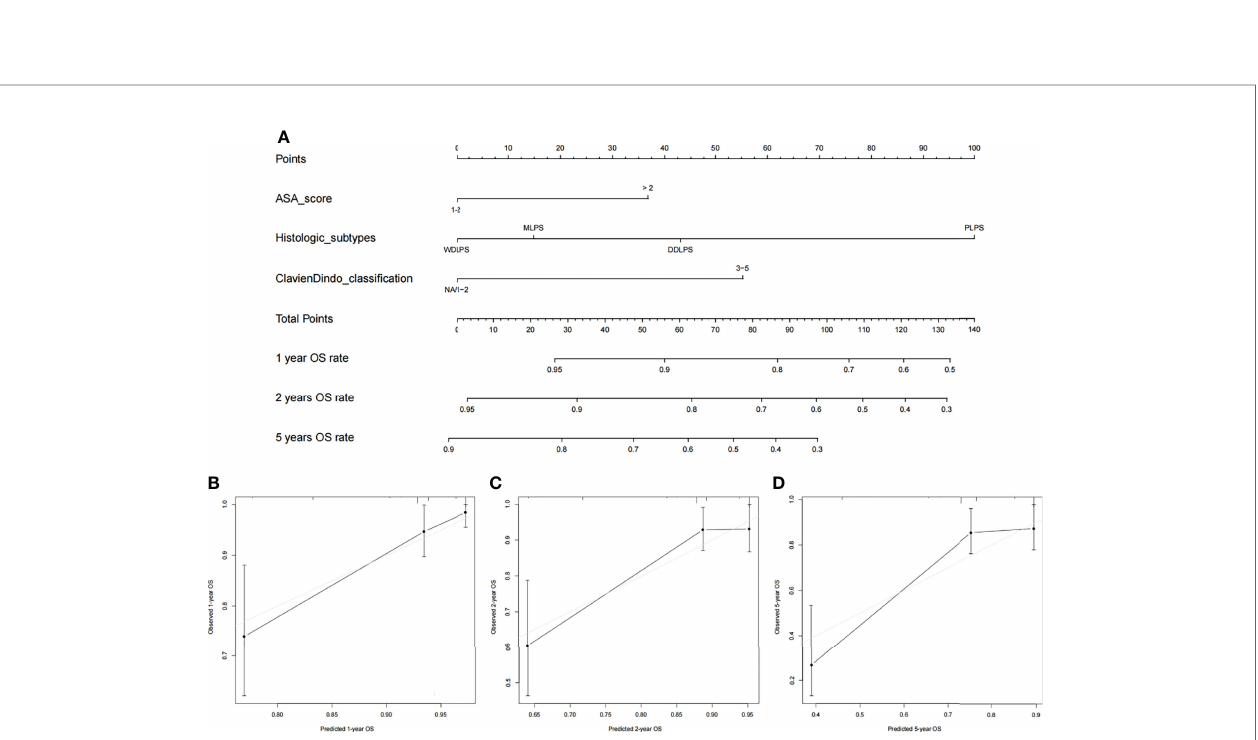
FIGURE 4 | (A) Nomogram for 1-, 2-, and 5-year overall survival in patients with primary retroperitoneal liposarcoma and calibration plots for internal validation of (B) 1-, (C) 2-, and (D) 5-year overall survival nomogram.